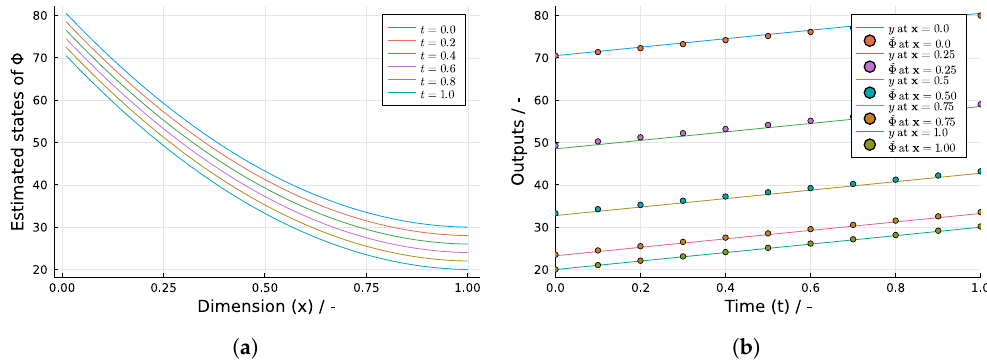
Figure 6. Model response for Scenario 2 assuming a boundary control problem with ( a ) for the recalculated diffusion profiles using the measured boundary value and ( b ) for the calculated diffusion profiles with the forward simulation output profiles.